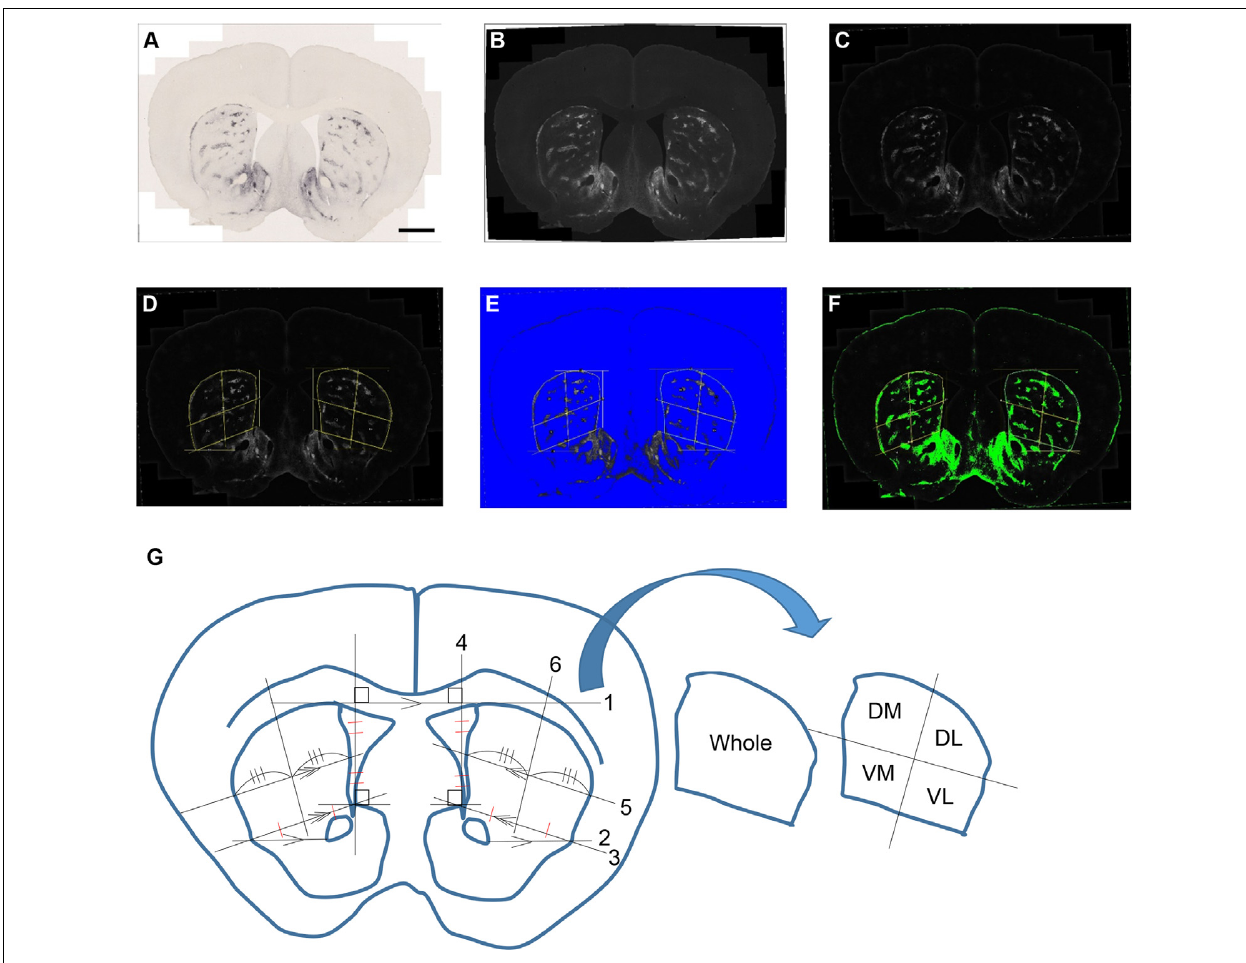
FIGURE 1 | An example of processing a raw image. The obtained raw image (A) was converted into a 16-bit grayscale and was inverted (B) . The background signals were subtracted using the “Rolling Ball” command (radius = 500 pixels) of Fiji software. Small noise was removed by the “Median Filter” command (radius = 5 pixels; C ). Each area was manually defined and divided into four areas for the bilateral caudoputamen (D,G) . The threshold was defined in the image from each area using the Li method for the demarcation of striosome (E) and matrix (F) compartments. Analyses of the percentage area of striosomes and densitometric data of both compartments were performed for each area. The manual demarcation of the caudoputamen was performed as described below (G) : (1) Draw the tangent line (line 1) between right and left caudoputamen. (2) Draw the parallel line (line 2) to line 1 from the lateral tip of the anterior commissure. (3) Draw the line (line 3) from the upper tip of the nucleus accumbens shell to the cross point of line 2 and the lateral margin of the caudoputamen. (4) Draw the line (line 4) vertically to line 1 from the upper tip of the nucleus accumbens shell. (5) Draw the parallel line (line 5) to 3 from the midpoint of 4. (6) Divide line 4 and the striatal portion of lines 3 and 5 evenly. (7) Draw the line (line 6) going through the midpoints of lines 3 and 5 as defined in (5). (8) Repeat (2–7) on the other side. (9) Outline manually whole, dorsomedial (DM), dorsolateral (DL), ventromedial (VM), and ventrolateral (VL) caudoputamen and save it to the ROI